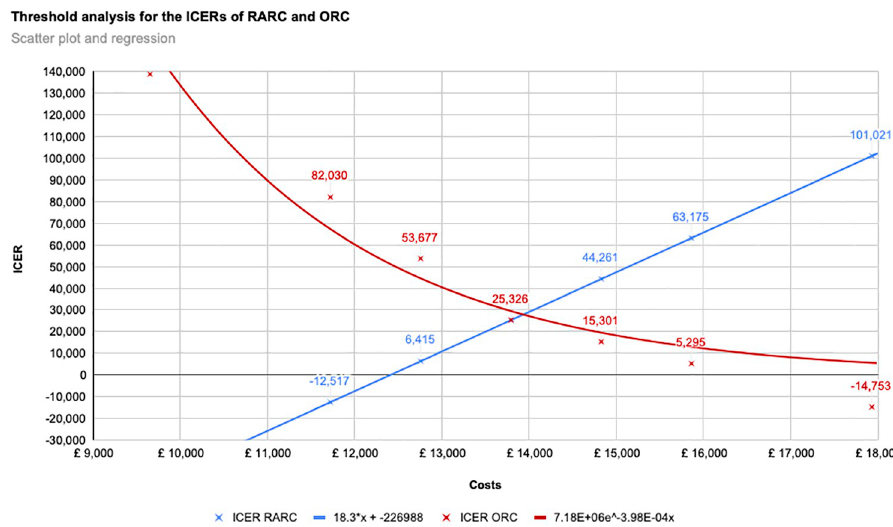
Fig 5. Threshold analysis for the ICERs of RARC and